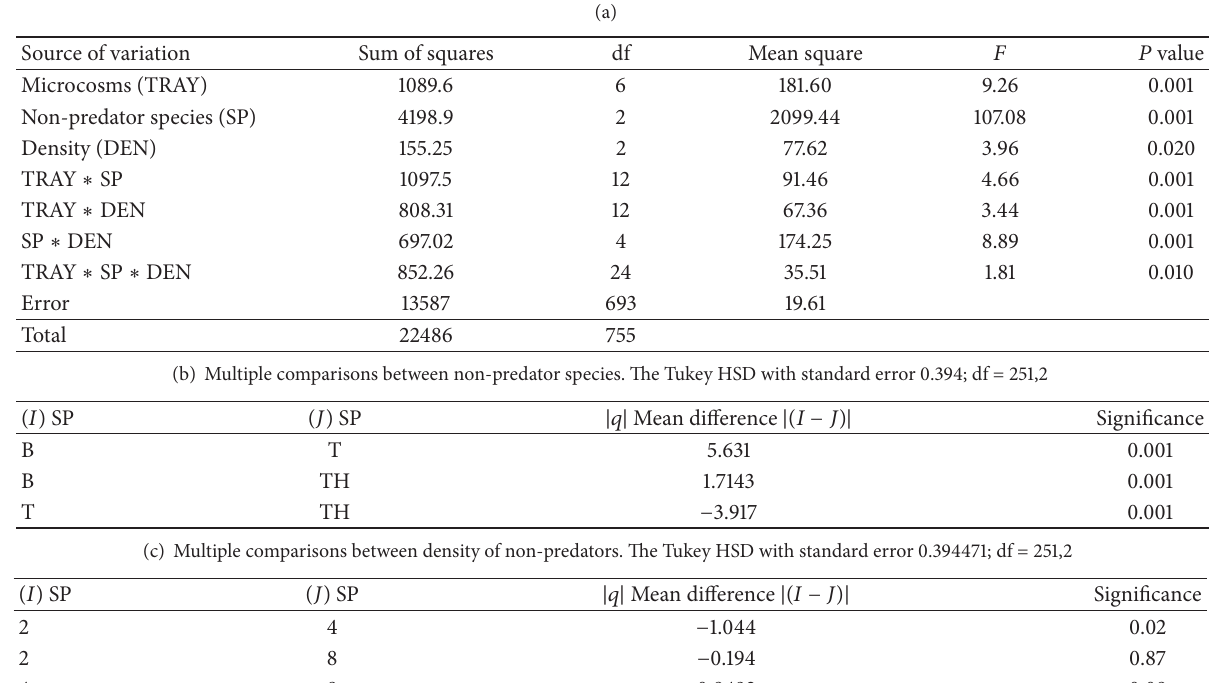
Table 1: The results of 3-way factorial ANOVA on the effects of non-predators on the tube numbers per quadrat ( 10 ∗ 10.7 cm 2 ) when the non-predators were present as separately as individual